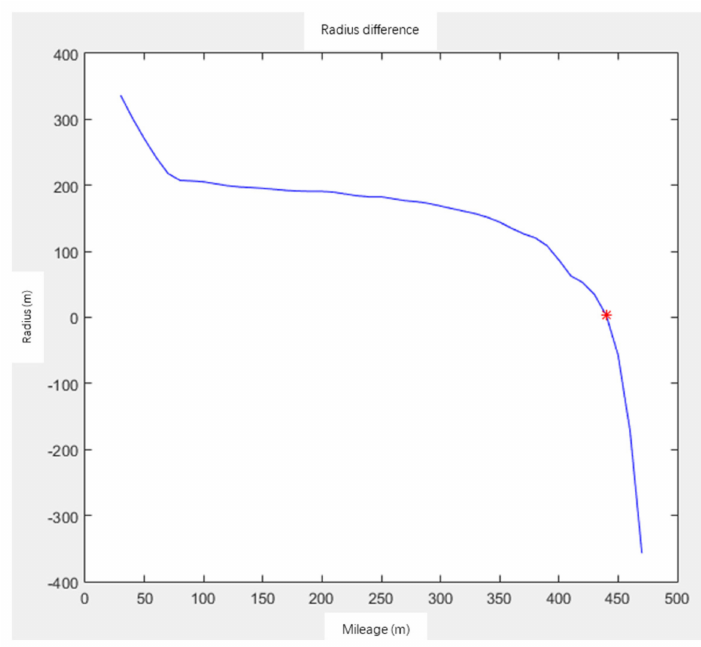
Figure 8. Radius difference of each